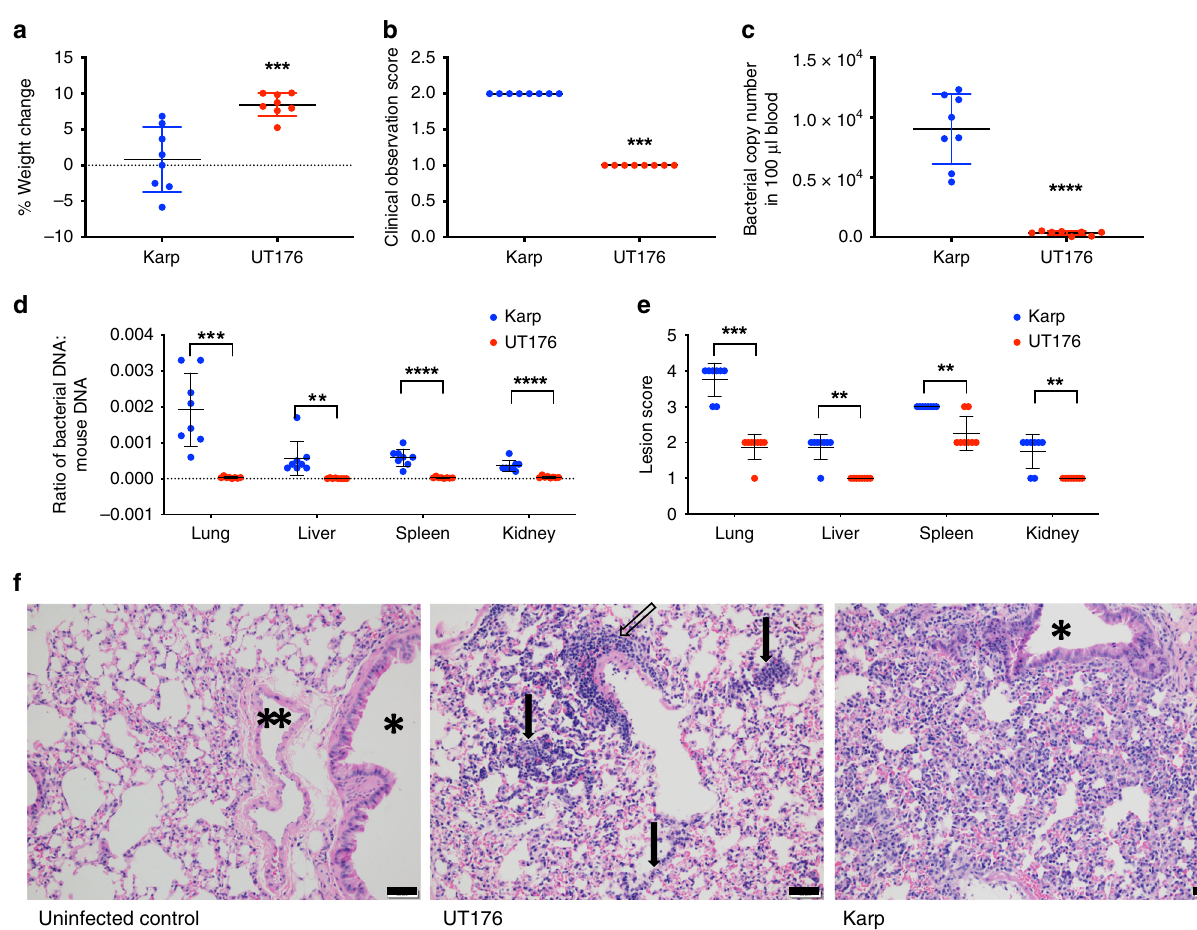
Fig. 7 Karp is more virulent than UT176 in a mouse infection model. a Weight change over 12 days of infection. b Clinical observation score of mice 12 days post infection. This number is a composite score based on appetite, activity, and hair coat with higher numbers representing low appetite, low activity, and ruf fl ed fur. Details provided in Supplementary Fig. 19. c Bacterial genome copy number in 100 µ l blood taken from euthanized mice 12 days post infection, measured by qPCR. d The ratio of bacterial genome copy number to mouse genome copy number in lung, liver, spleen, and kidney of euthanized mice 12 days post infection, measured by qPCR. e Lesion scores of hematoxylin and eosin-stained lung, liver, spleen, and kidneys of euthanized mice 12 days post infection. Scores range from 0 to 5 with 0 representing normal tissue and 5 representing severe lesion damage. All graphs show mean and standard deviation. Statistical signi fi cance is calculated using unpaired Student t -test in GraphPad Prism software. ** p ≤ 0.01 *** p ≤ 0.001 **** p ≤ 0.0001. f Images of hematoxylin and eosin-stained lung tissue of mice infected with buffer, UT176 or Karp. Scale bars = 50 µ m. * indicates airway and ** indicates blood vessel. Uninfected control: airway, blood vessel, and alveoli all appear normal. UT176-infected lungs: there are diffuse thickening and in fi ltration of alveolar septa with a mixed population of macrophages and lymphocytes (arrows). There is also mild perivascular lymphohistiocytic in fl ammation (open arrow). Karp-infected lungs: there is diffuse moderate thickening and in fi ltration of alveolar septa with a mixed population of macrophages and lymphocytes. The airway (*) is unaffected and normal. Additional fi gures are shown in Supplementary Fig. 19. Mean and SD from eight individual mice is shown. Source data are provided as a Source Data fi